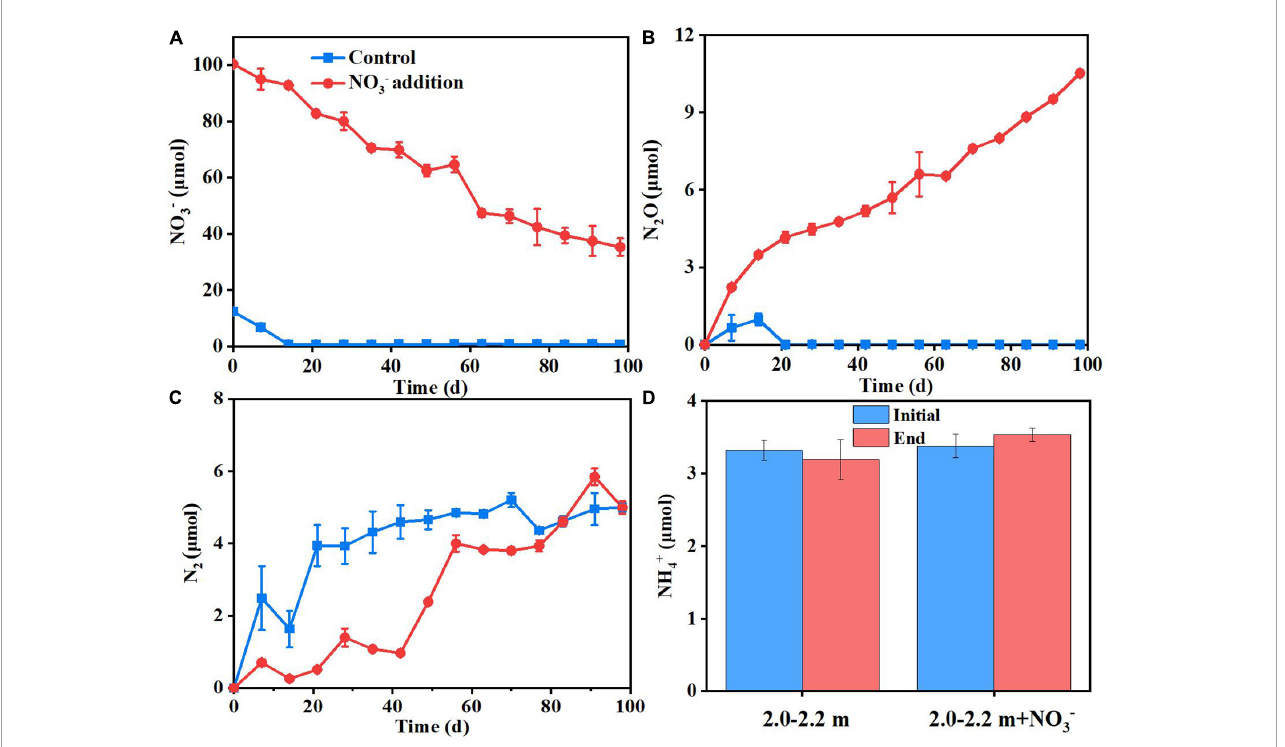
FIGURE3 Dynamics of NO 3 – (A) , N 2 O (B) , and N 2 (C) concentrations in flasks under control and nitrate addition treatments. NH 4 + concentrations at initial and end of the incubation under two treatments (D)